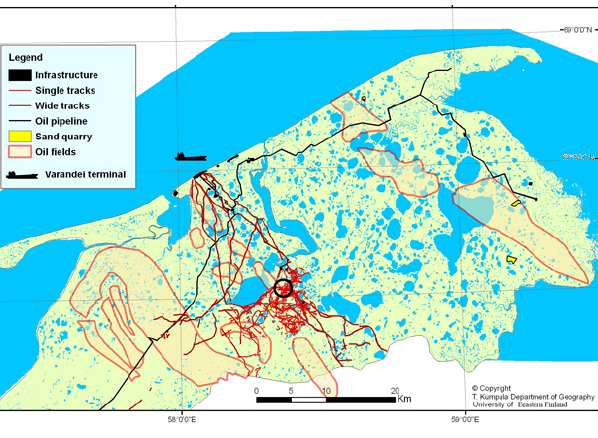
Fig. 5 . Oil fields and infrastructure in the Varandei region, Nenets Autonomous Okrug. Toravei field is indicated by the high density of tracks from off-road vehicle traffic in the lower center portion of the